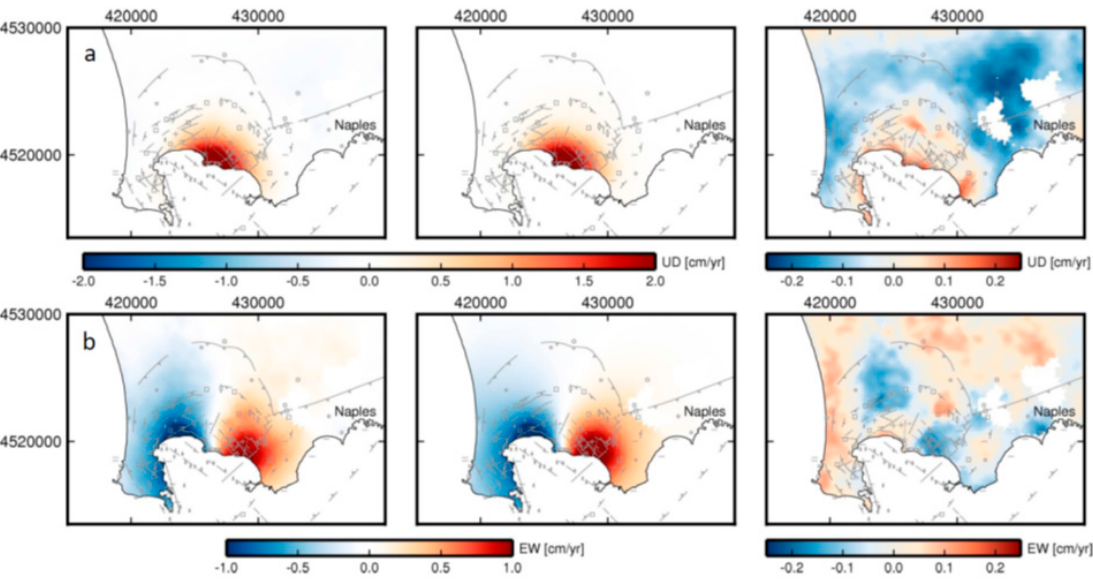
Figure 15. ( a ) Observed vertical displacement rate (left), cm / yr, for the subsidence period, 2007–2013; modelled vertical displacement rate from inversion (center); and residual of observed and modelled displacements (right). ( b ) Observed EW displacement rate (left), cm / yr, 2007–2013; modelled EW displacement from inversion (center); and residual of observed and modelled displacements (right). Images were saturated at the corresponding scales in order to improve comparison and highlight di ff erences among panels